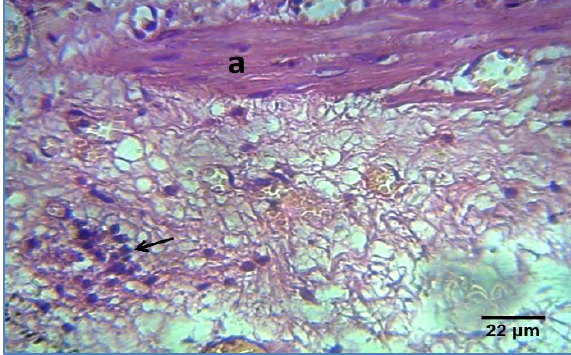
Figure, 7: Shows bundle of connective tissue (a). Aggregationof mononuclear cells (Arrow). H and E stain. (grade, 1), 7th day post-operation, in group B.